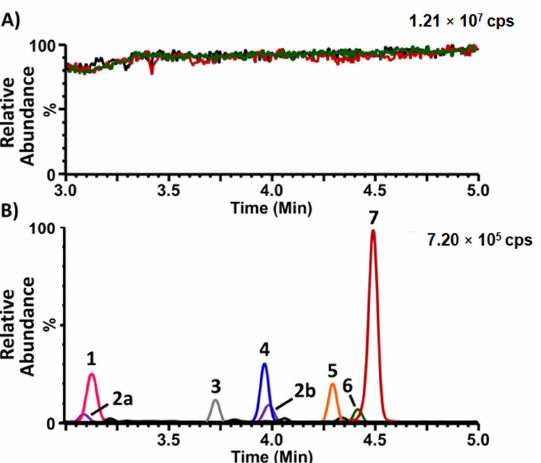
Figure 1. Matrix effect evaluation for the analysis of lyso ‐ Gb 3 and its analogues in dried blood spots (DBSs). ( A ). Signal obtained from the post ‐ column infusion of lyso ‐ Gb 3 ‐ 13 C 6 (500 nM in: 50% ace ‐ tonitrile, 49.9% H 2 O, 0.1% formic acid) at a flow rate of 10 μ L/min during the UHPLC injection of: (1) the resuspension solvent (50% acetonitrile, 49.9% H 2 O, 0.1% formic acid) (green line); (2) a What ‐ man ‐ GE 903 ‐ collected DBS prepared with control blood (post ‐ sample preparation, red line); and (3) a Capitainer ® B ‐ collected DBS prepared with control blood (post ‐ sample preparation, black line). ( B ). Multiple reaction ‐ monitoring (MRM) analysis of lyso ‐ Gb 3 and its analogues in a Whatman ‐ GE 903 ‐ collected DBS prepared with blood from an untreated Fabry male; 1: analogue (+16 Da); 2a and 2b: analogue (+34 Da); 3: analogue ( − 28 Da); 4: analogue ( − 2 Da); 5: lyso ‐ Gb 3 ‐ Gly (internal standard); 6: analogue (+18 Da); and 7: lyso ‐ Gb 3 ). cps = counts per second.